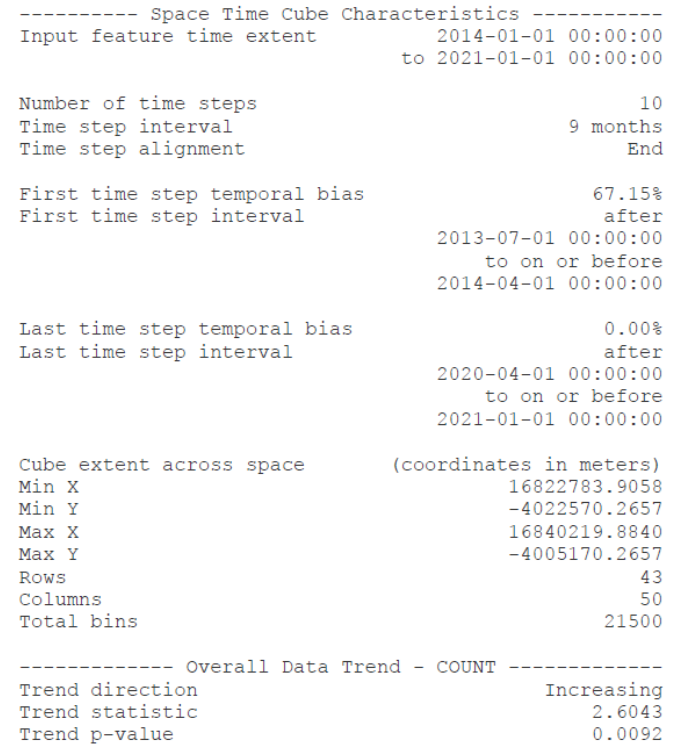
Figure A3. Small bar licence space-time cube logfile.